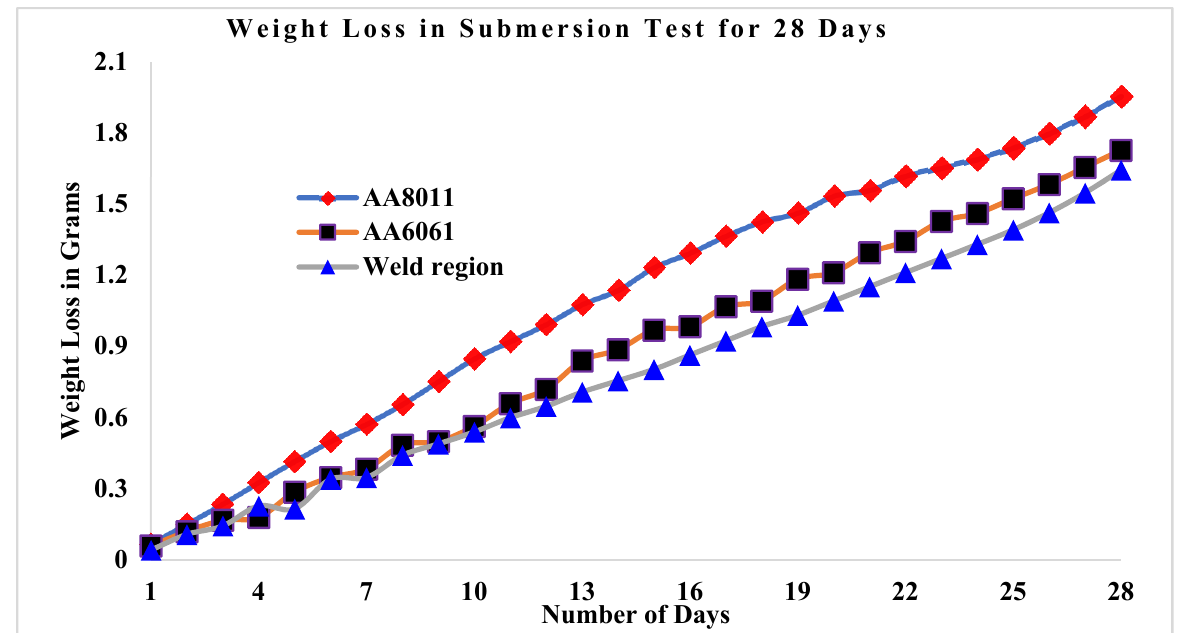
Figure 11. Weight loss rates for base materials and weld region sample against the number of days submerged in 3.5wt. % H 2 SO 4 + H 2 O.